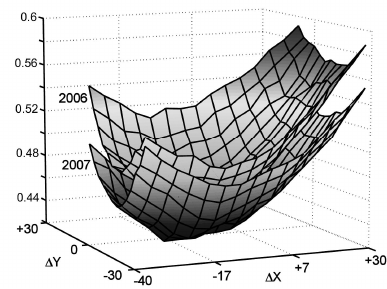
Fig. 4. Mean horizontal echo - stem distance (m) of the highest echo in understory trees as function of X and Y offsets (cm). Plot B, ALTM_06_1km and ALS50_07_1km data